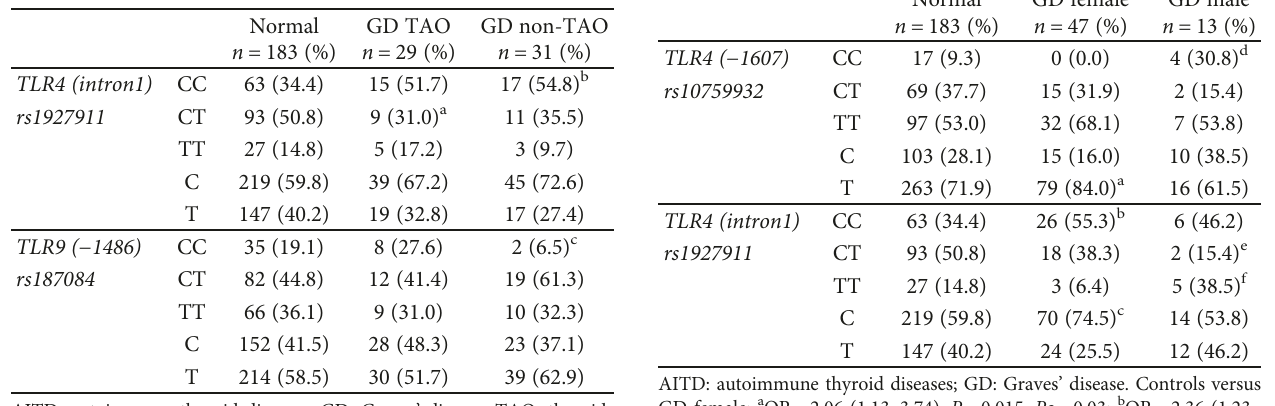
Table 4: Genotype frequencies of TLR4 genes between controls and patients with or without thyroid-associated ophthalmopathy in Graves ’ disease.